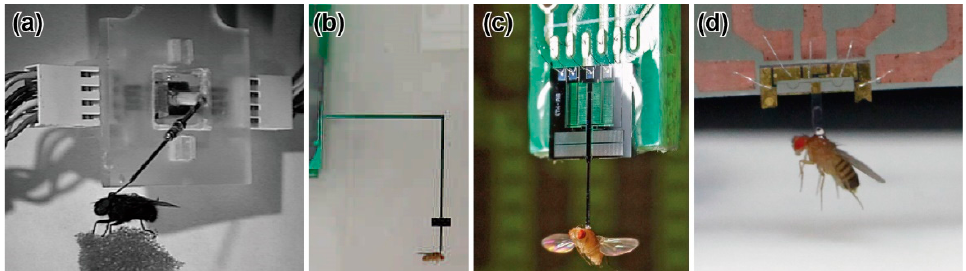
Figure 6. Photographs of flies attached to force probes. ( a ) Blowfly on a biaxial force probe. Reprinted/adapted with permission from [112]. 2022, IEEE. ( b ) Fruit fly on a biaxial MEMS piezoresistive force probe. Reprinted/adapted with permission from [30]. 2022, IEEE. ( c ) Fruit fly on a uniaxial MEMS capacitive force probe. Reprinted/adapted with permission from [33]. 2022, IEEE. ( d ) Fruit fly on a triaxial MEMS piezoresistive force probe. Reprinted/adapted with permission from [37]. 2022, IEEE.